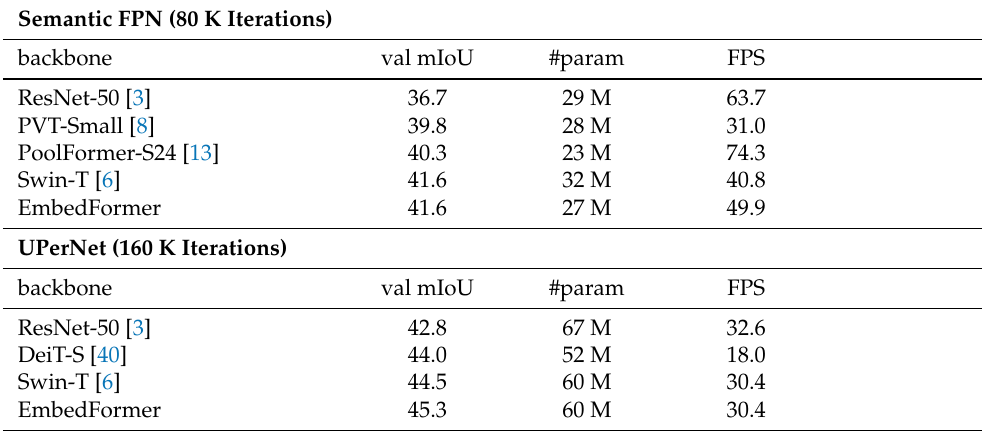
Table 3. The semantic segmentation results on ADE20K using Semantic FPN and UPerNet. The results of FPS are tested on one piece of